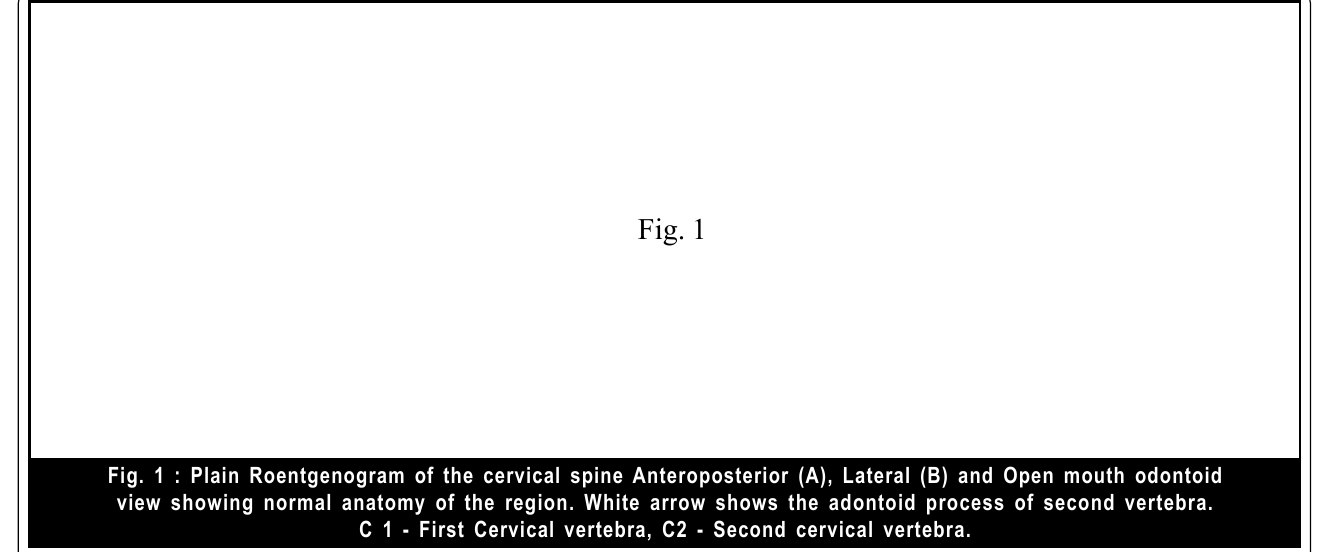
Fig. 1 : Plain Roentgenogram of the cervical spine Anteroposterior (A), Lateral (B) and Open mouth odontoid view showing normal anatomy of the region. White arrow shows the adontoid process of second vertebra.